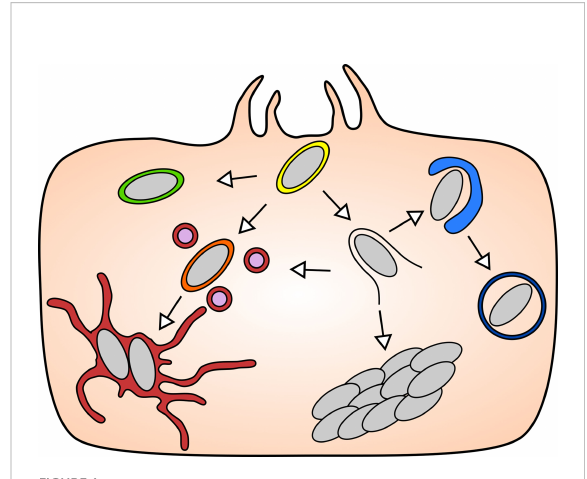
FIGURE 1 The diverse intracellular lifestyles of Salmonella : In the mammalian model systems, S . Typhimurium has been found to adopt a range of lifestyles of distinct features that are remarkable for their subcellular localizations and replication rates. Upon entry into the host cell (yellow), S . Typhimurium can opt to remain either inside the SCV, or to enter the host cytosol by rupturing the SCV. The vacuolar S . Typhimurium give rise to replicative (maroon) and non-replicative (green) subpopulation, while the cytosolic S . Typhimurium can be targeted by host autophagy (blue), or they hyper-replicate (bacterial cluster) or re-enter the SCV via repair of the damaged SCV